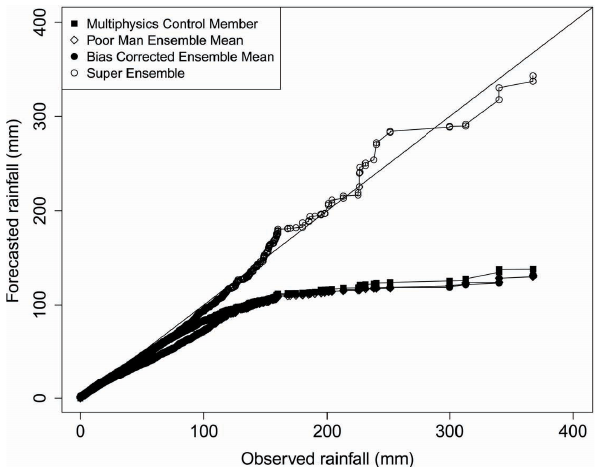
Fig. 5. Q-Q plot for the multiphysics ensemble control member, the multiphysics ensemble mean, the bias corrected ensemble mean and the superensemble, as functions of different rainfall event